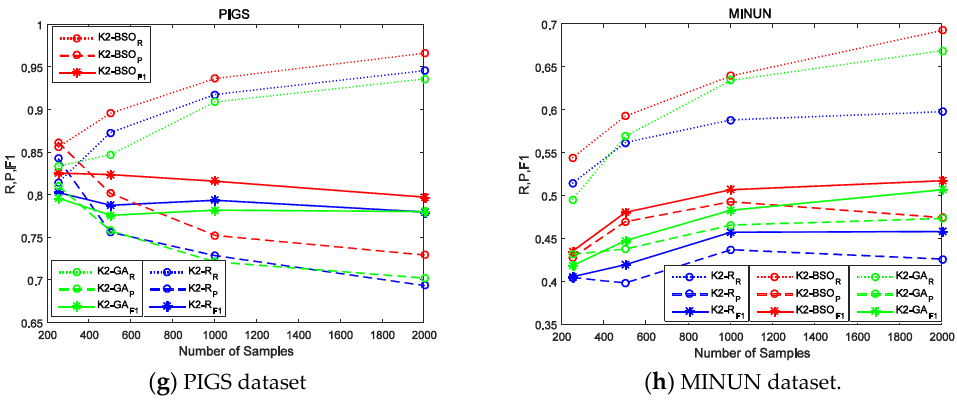
Figure 2. R, p & F1 of the K2-R, K2-BSO and K2-GA with eight dataset: ( a ) ASIA dataset; ( b ) SACHS dataset; ( c ) CHILD dataset; ( d ) ALARM dataset; ( e ) BARLEY dataset; ( f ) Win95pt dataset; ( g ) PIGS dataset; ( h ) MINUN dataset.